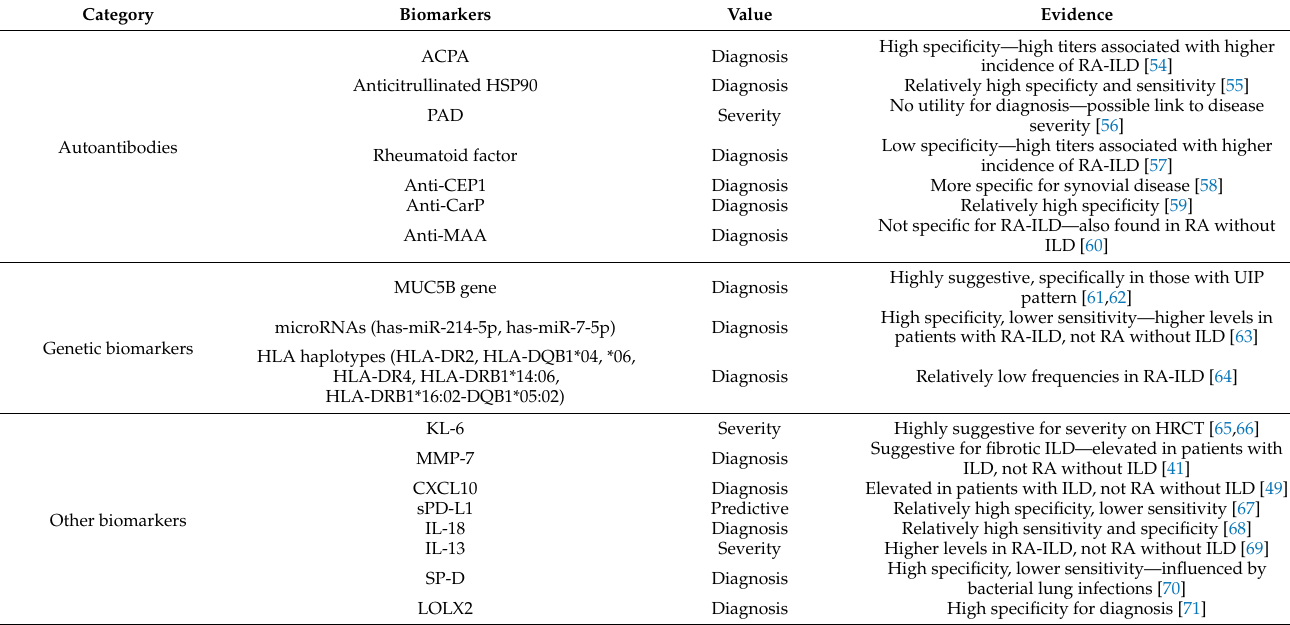
Table 1. Value of biomarkers in